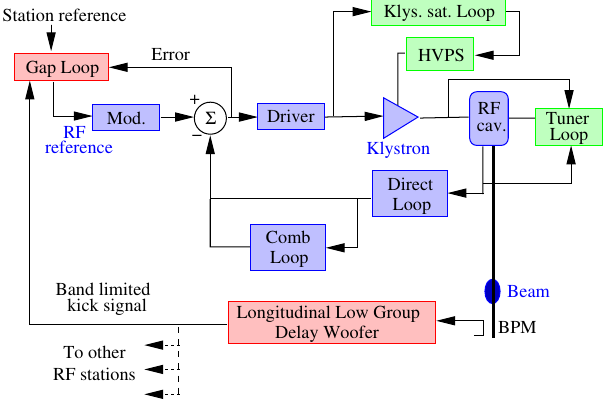
FIG. 18. (Color) Block diagram of an impedance controlled rf system used at PEP-II. In the actual implementation, each rf station had one 1.2 MW klystron and 2 or 4 HOM-damped rf cavities. The LLRF systems used direct and comb loops, klys- tron HV regulating loops, gap feed-forward loop, and other low- frequency regulators. The broadband longitudinal processing is implemented once per ring, as is the low group delay woofer processing. From the LGDW band-limited kick information is sent to selected stations around the ring via fiber optic digital data